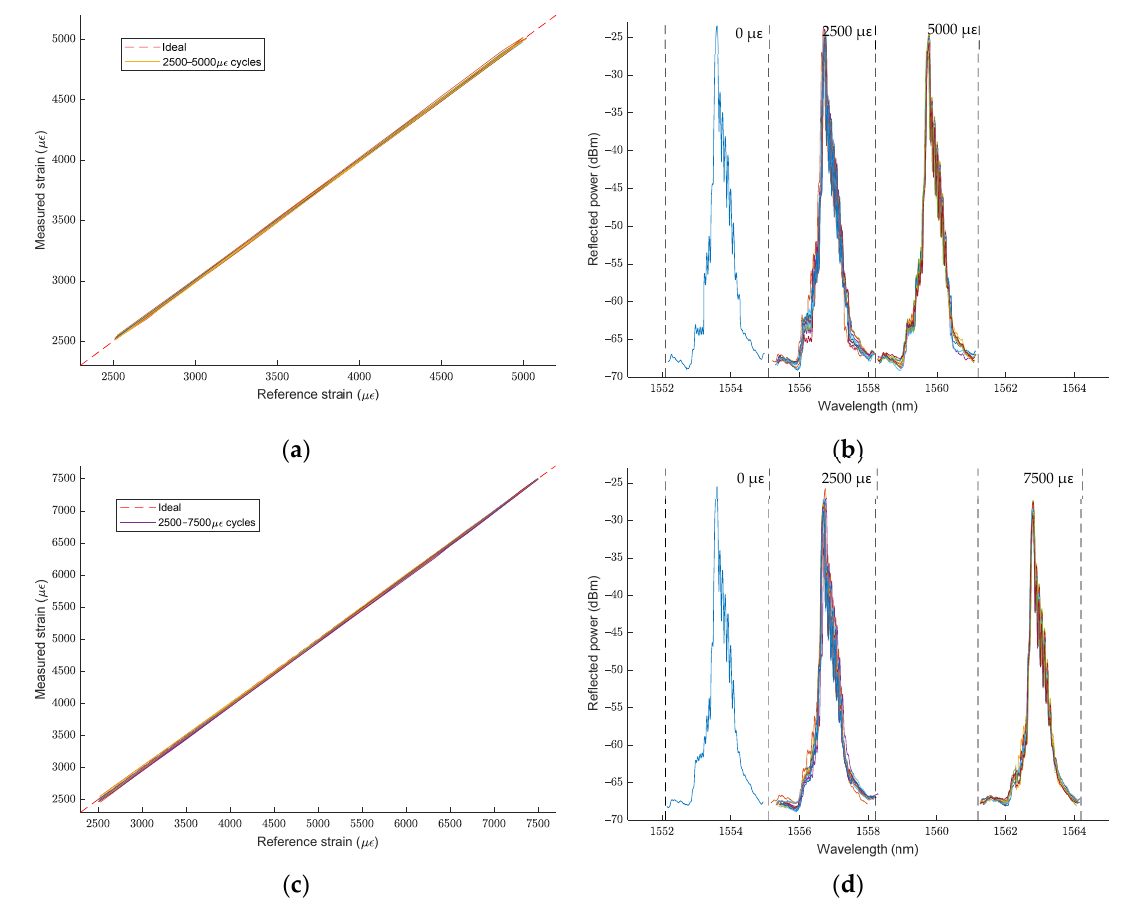
Figure 8. Sensor 2 strain readings: ( a ) accuracy at 0.25–0.50% strain cycles; ( b ) FBG spectrum conservation at 0.25–0.50% strain cycles; ( c ) accuracy at 0.25–0.75% strain cycles; ( d ) FBG spectrum conservation at 0.25–0.75% strain cycles.